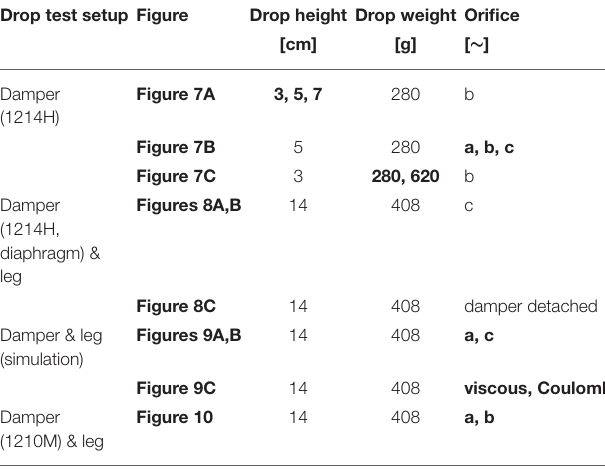
TABLE 3 | Drop test settings for experiments. Drop test setup